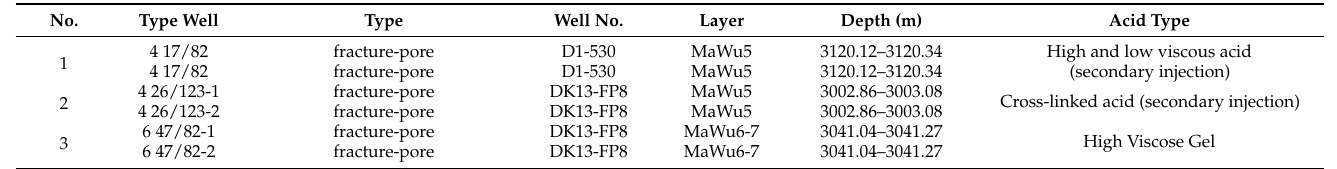
Table 2. The preferred experimental scheme for different acid fracturing processes for three different reservoir types.